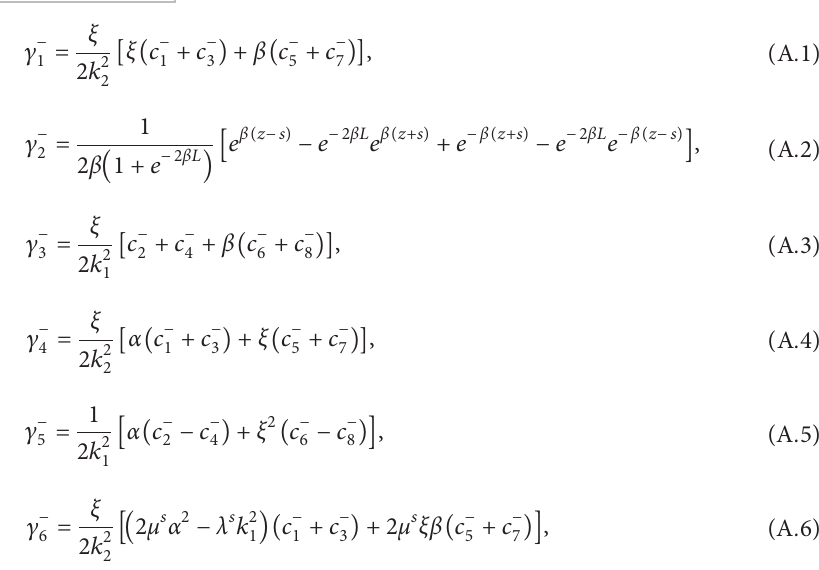
s � 2 r , ω � 0 . 5): (a) real part of lateral s ( 0